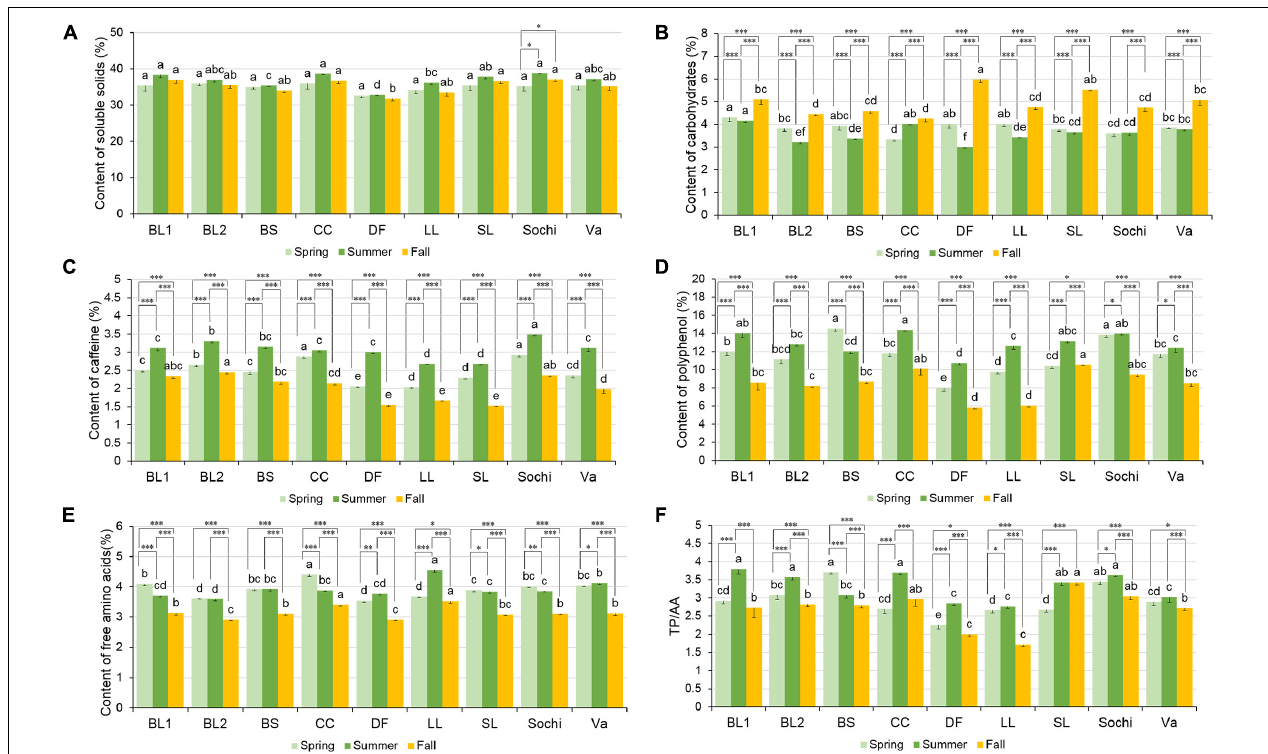
FIGURE 2 | Content of soluble solids (dry weight%) (A) , carbohydrates (dry weight%) (B) , caffeine (dry weight%) (C) , total polyphenols (dry weight%) (D) , free amino acids (AA) (dry weight%) (E) , and ratio between total polyphenols and free amino acids (TP/AA) (F) in tea extract of nine cultivars grown in Mississippi, United States. ‘BS’ stands for cultivar ‘Black Sea,’ ‘CC’ stands for cultivar ‘Christine’s Choice,’ ‘DF’ stands for cultivar ‘Dave’s Fave,’ ‘LL’ stands for cultivar ‘Large Leaf,’ ‘SL’ stands for cultivar ‘Small Leaf,’ ‘Va’ stands for cultivar ‘var. assamica .’ Different lower case letters on top of the same colored bars suggest significant difference in soluble solid content among nine cultivars within one harvesting season indicated by Tukey’s HSD test at P ≤ 0.05; ∗ suggests significant difference within one cultivar among different harvest seasons at P ≤ 0.05; ∗∗ suggests significant difference within one cultivar among different harvest seasons at P ≤ 0.01; ∗∗∗ suggests significance different within one cultivar among different harvest seasons at P ≤